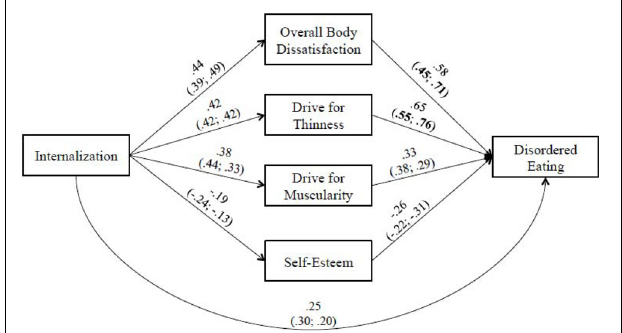
FIGURE 1 | Model of the relationship between internalization of socio-cultural standards of beauty and disordered eating for men. Revised model with significant paths added. Path coefficients for the full sample of men as well as for the sub-samples of heterosexual (right side) and gay/bisexual men (left side) are presented (all ps < 0 . 05). The bold values within parentheses indicate a significant difference between heterosexual (right side) and gay/bisexual (left side) men.